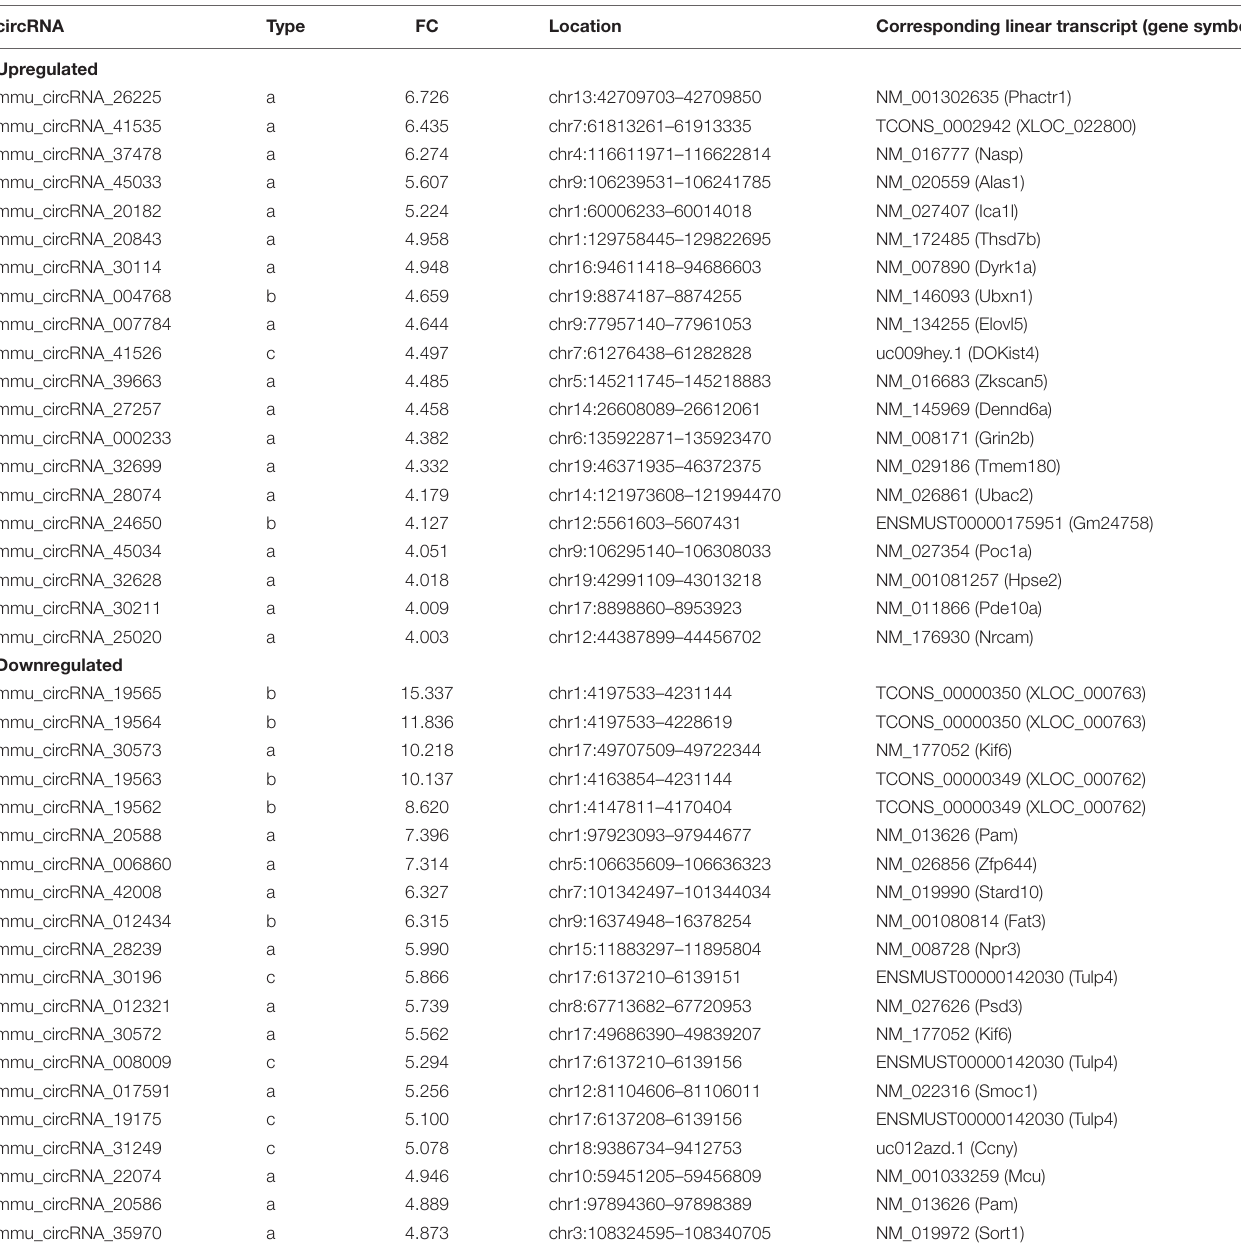
TABLE 3 | Top 40 significantly dysregulated circular RNAs (circRNAs) in 2W-post-TAC mouse heart. circRNA Type FC Location Corresponding linear transcript (gene